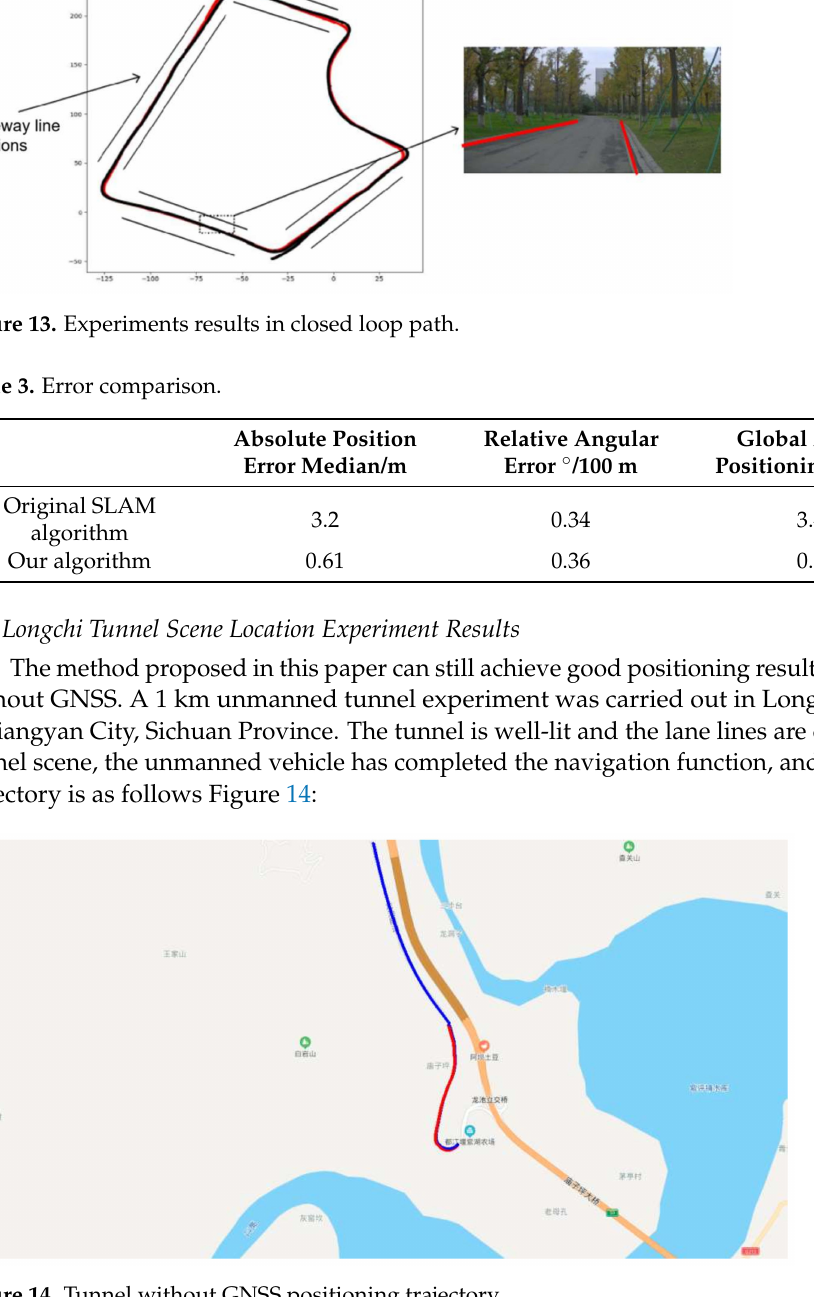
Figure 14. Tunnel without GNSS positioning